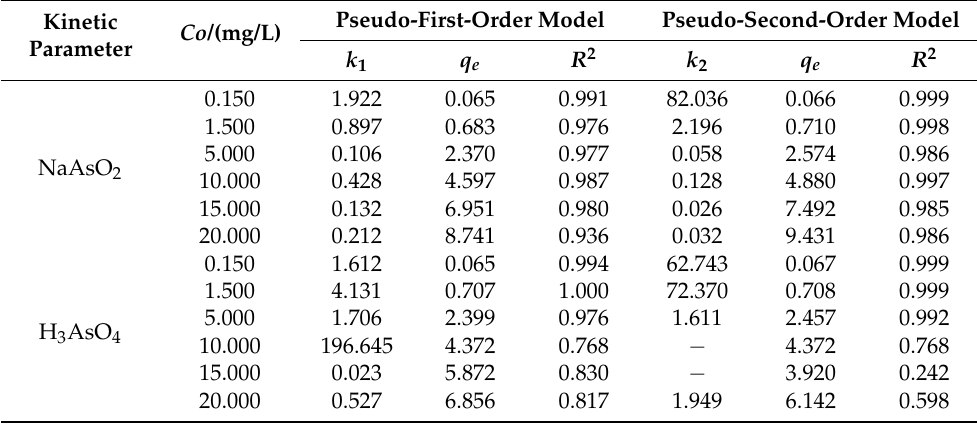
Table 4. Parameter of pseudo-first-order and pseudo-second-order